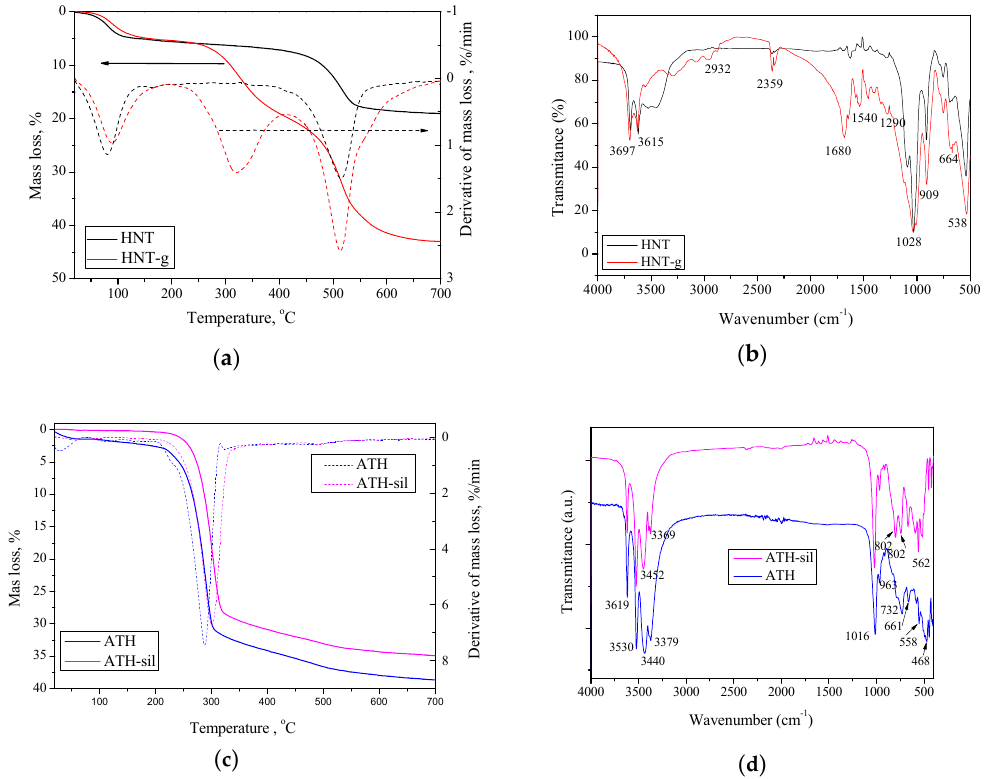
Figure 2. TG curves ( a ) and FTIR spectra ( b ) of pristine HNTs and gelatin-modified HNTs; TG curves ( c ) and FTIR spectra ( d ) of pristine ATH and silane-modified ATH.